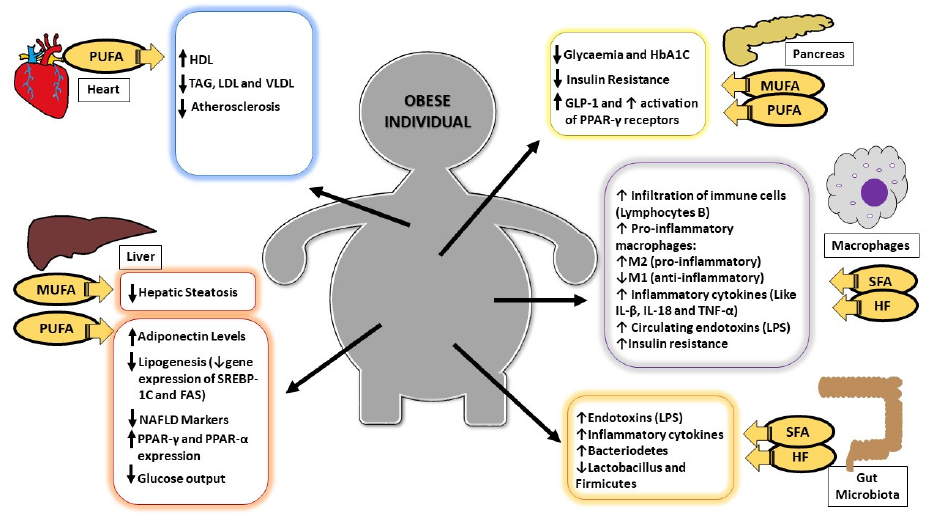
Figure 1. Different metabolic changes involved after consumption of different types of fatty acids: saturated (SFA), monounsaturated (MUFA), and polyunsaturated (PUFA) fatty acids. Different types of fatty acids have different effects on the major metabolic organs of the body. Diets with high levels of SFA, especially high fat (HF), modulate the inflammatory process with the infiltration of macrophages and other immunological cells, promoting higher production of type M2 macrophages, considered pro-inflammatory, with a reduction in type M1 macrophages, which are anti-inflammatory, in addition to the expression of inflammatory cytokines and circulating endotoxins, which promote insulin resistance. This inflammatory process is related to the microbiota, which also has a greater expression of inflammatory endotoxins and cytokines, as well as transitions in intestinal colonization, with increase of strains of the genus Firmicutes, and decrease of Bacteroidetes and Lactobacillus genus after consumption of HF diets rich in SFA. On the other hand, the consumption of MUFA and PUFA has positive effects on glucose metabolism, with a reduction in some parameters related to type II diabetes mellitus (DM II), such as hemoglobin A1c (HbA1c) and glycaemia, and a reduction of hepatic steatosis and related parameters. Intake of PUFA is linked to increased expression of adiponectin, an anti-inflammatory cytokine, which promotes hepatic metabolic enhancement, and reduces the risk of atherosclerosis, such as increased high density lipoprotein (HDL) and decreased triacyclglycerols (TAG). LDL; very low density lipoprotein (VLDL); glucagon-like peptide-1 (GLP-1) receptor; peroxisome proliferator-activated receptor- γ (PPAR- γ ); free fatty acids (FFA); sterol regulatory element-binding protein -1C (SREBP-1C); Non-alcoholic fatty liver disease (NAFLD); interleukin (IL); tumor necrosis factor (TNF); lipopolyssacharide (LPS); high fat (HF).